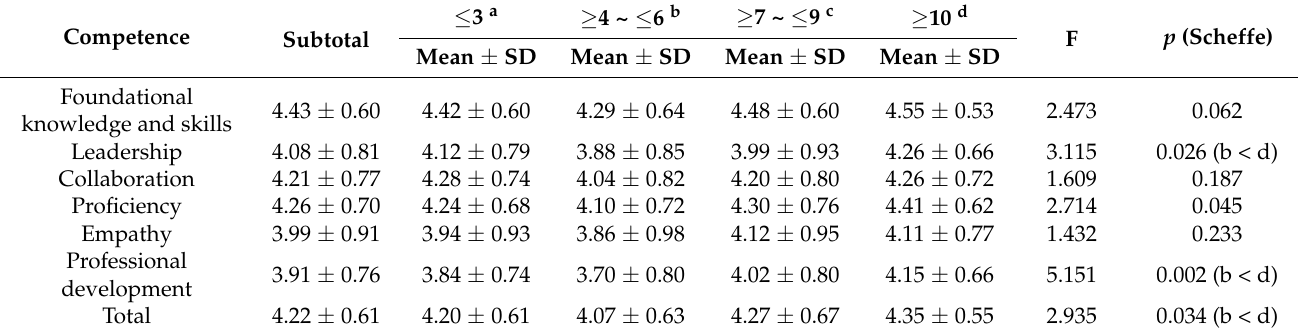
Table 3. Level of educational needs and differences among clinical